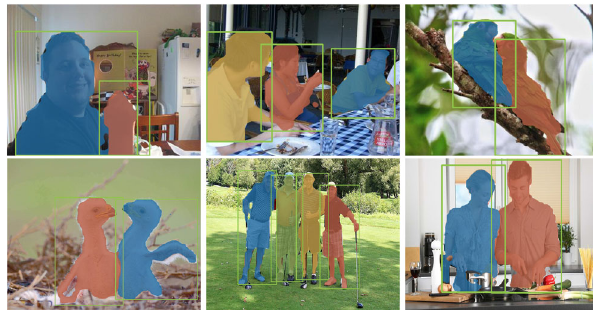
Fig. 1 Example salient instances output by our approach, which detects and segments them regardless of their semantic category. Each category-agnostic salient instance is highlighted with a unique color. Our results provide well-segmented candidates of interest to users, significantly reducing human efforts needed for image